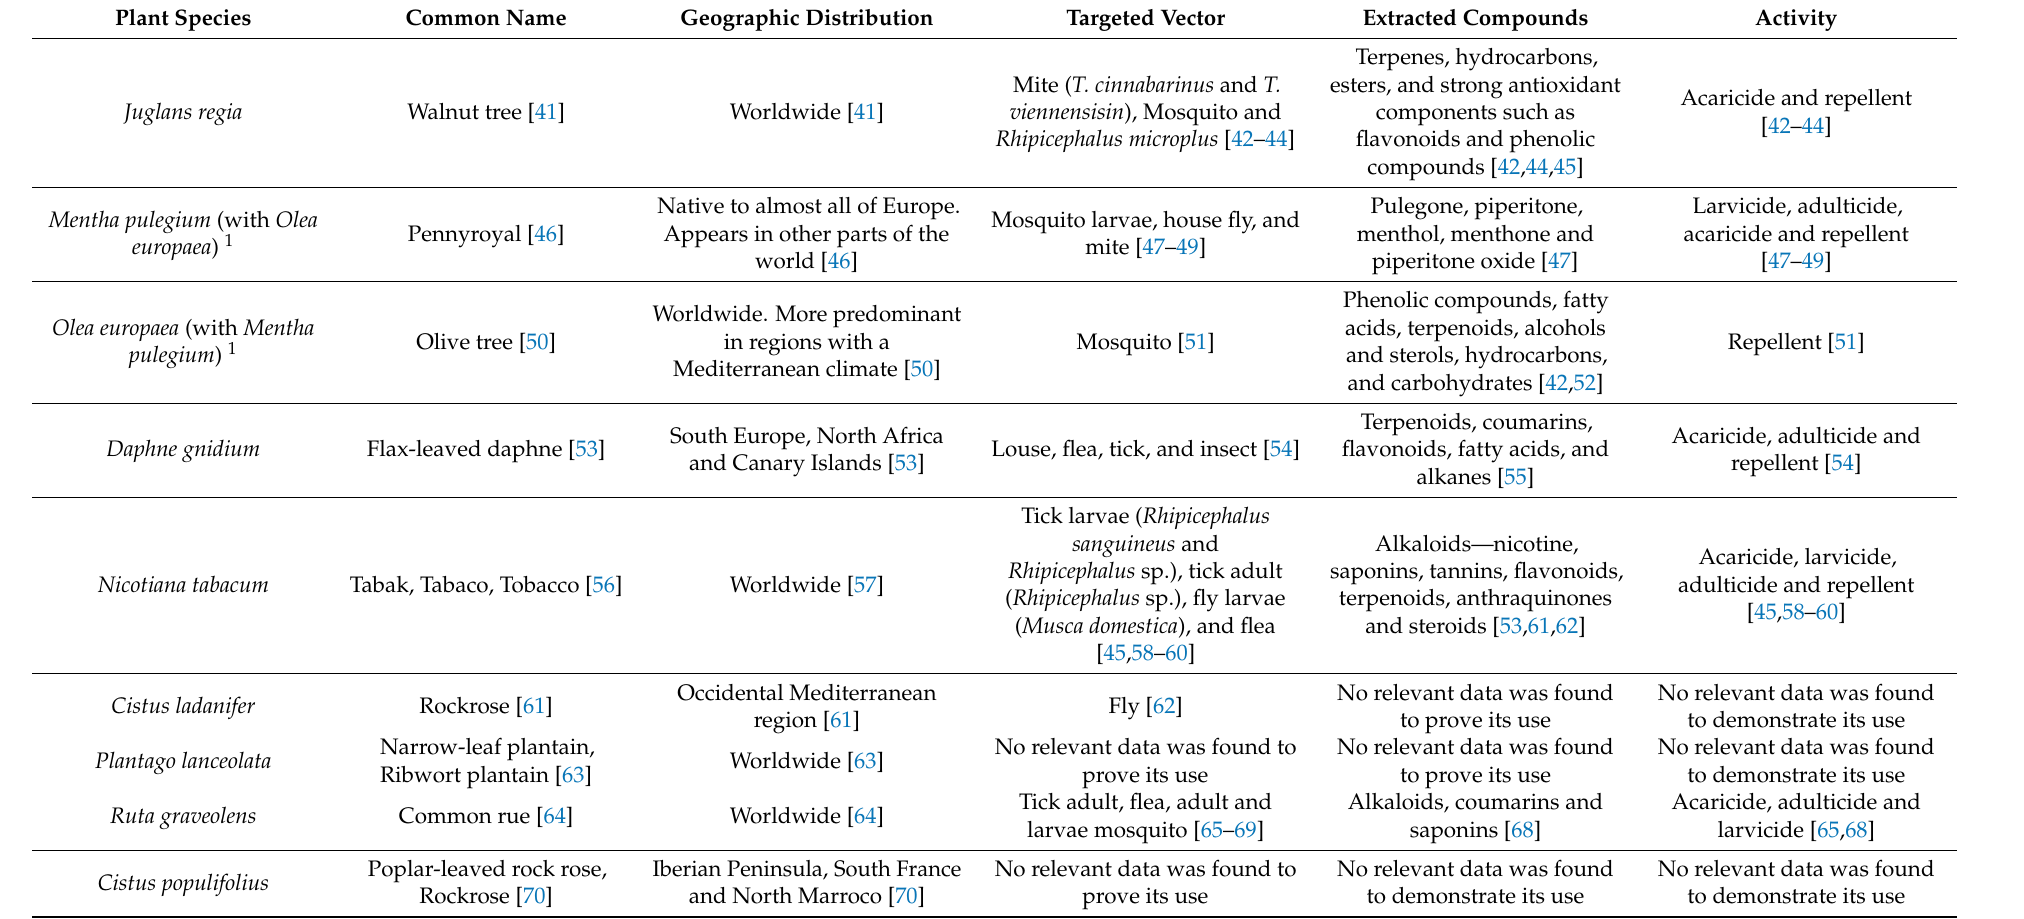
Table 3. Plants species with ectoparasiticide potential for dogs and some